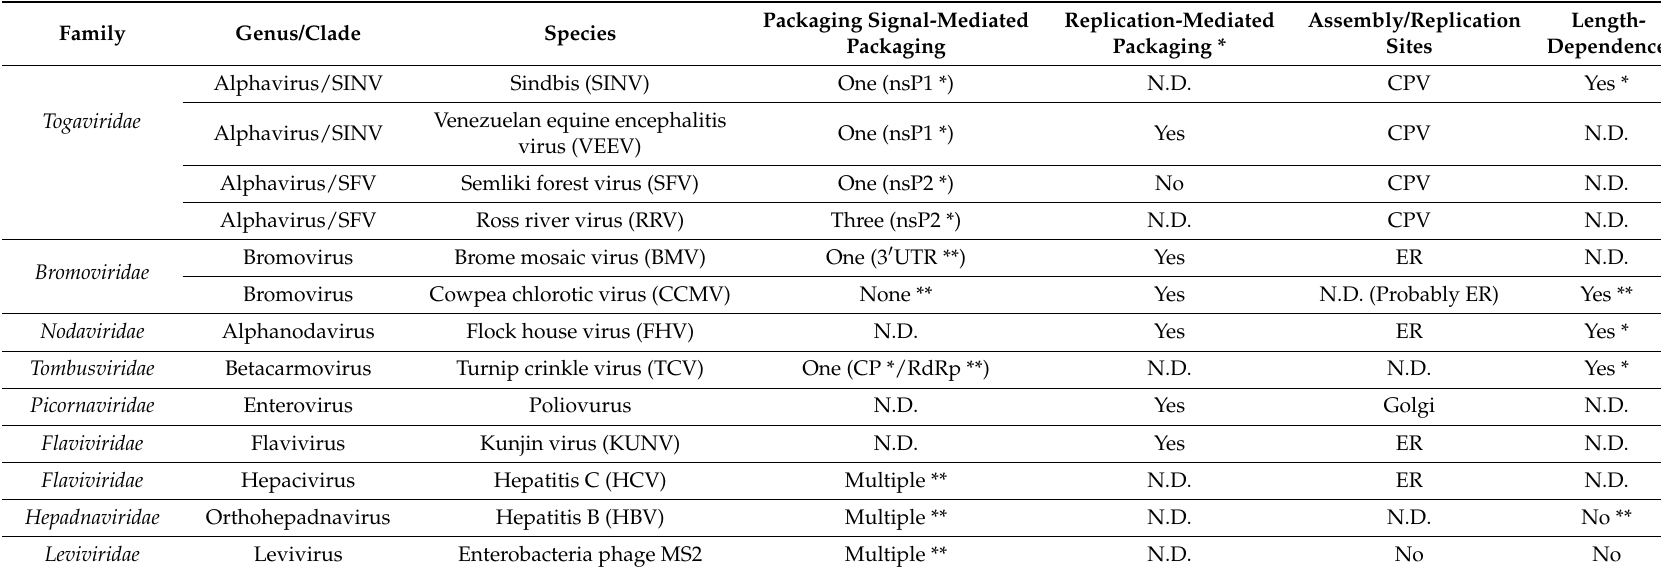
Table 1. Summary of some of the interactions required for selective packaging of the gRNA. This process can require a PS, assembly/replication sites (viral factories) and/or RNA replication by the RdRp. In some cases, it is not known if there are PS. Also, the contribution of some of these factors has not been determined. * Refers to experiments done in cultured cells or protoplasts, ** indicates experiments done in vitro with reconstituted components, N.D., not determined and CPV means cytopathic vacuoles (see Section